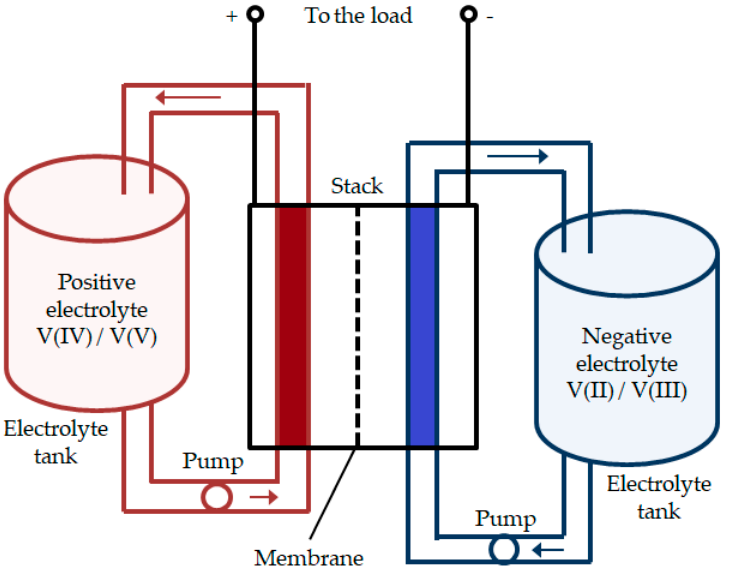
Figure 6. VRB electrochemical cell.